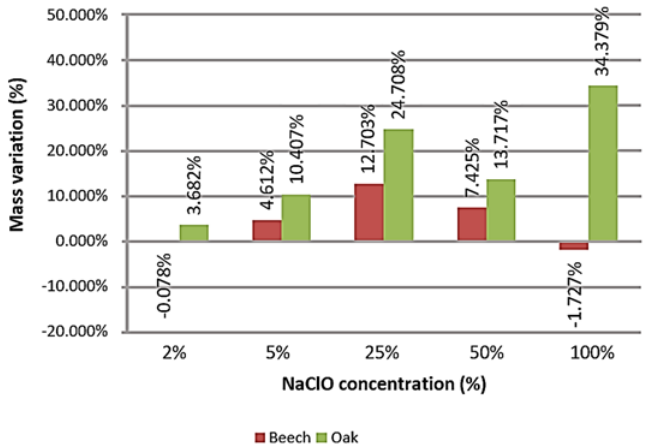
Figure 6. Mass variation of the small samples after three months of immersion